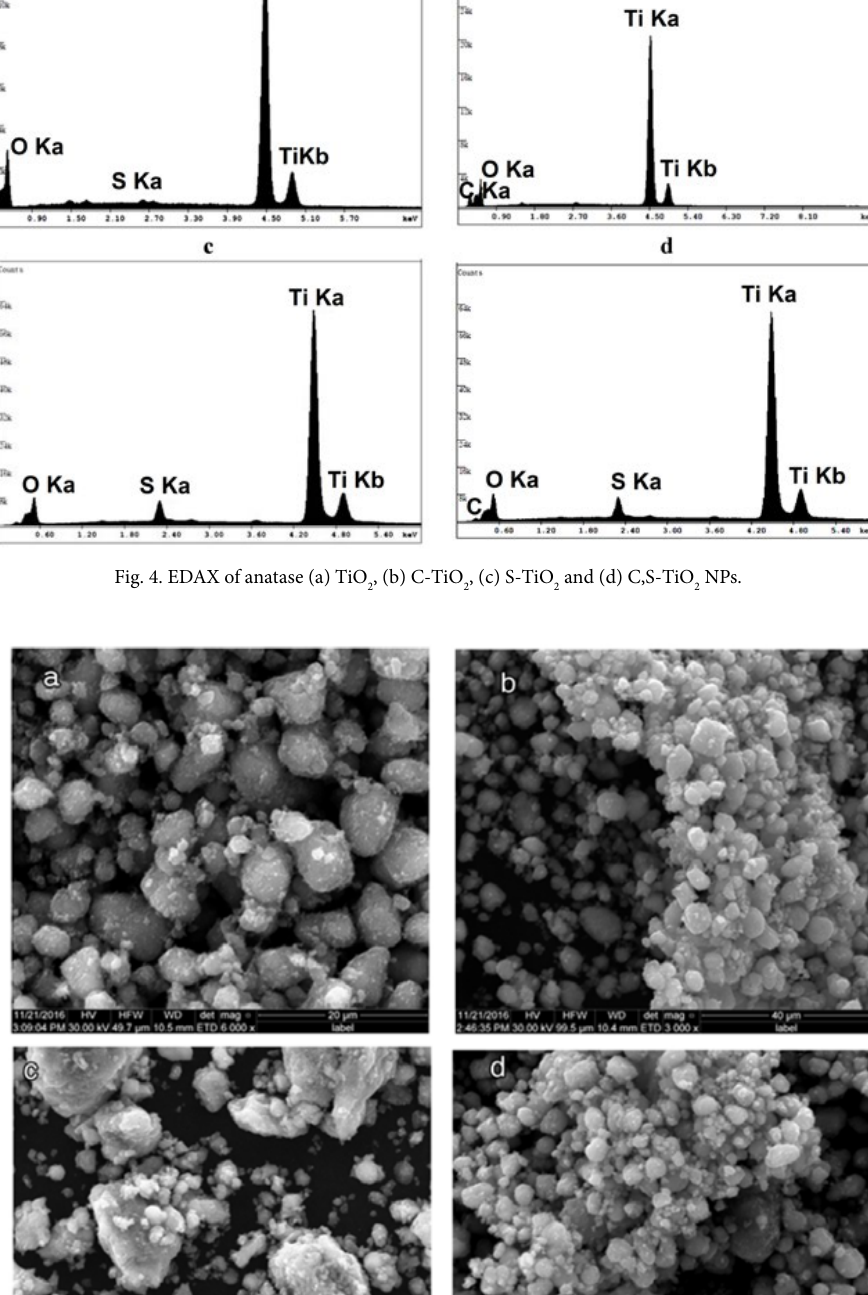
, (b) C-TiO , (c) S-TiO and (d) C,S-TiO 2 2 2 2